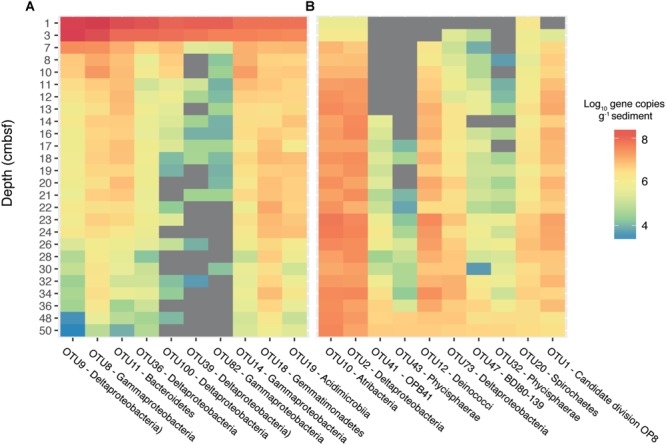
Estimated absolute abundances of the most dominant OTUs identified by sequencing of 16S rRNA gene. Absolute abundances were calculated by multiplying relative sequence abundances by gene copy numbers obtained from qPCR of the 16S rRNA gene, assuming an average of 4.1 and 1.6 16S rRNA operons per cell for bacteria and archaea, respectively. The top ten most abundant OTUs present at 3 cmbsf are displayed in (A) and the top ten most abundant OTUs present at 50 cmbsf are displayed in (B). The color represents the log10 absolute abundance of each OTU. Gray areas represent depths where no sequences were recovered for the specified OTU.